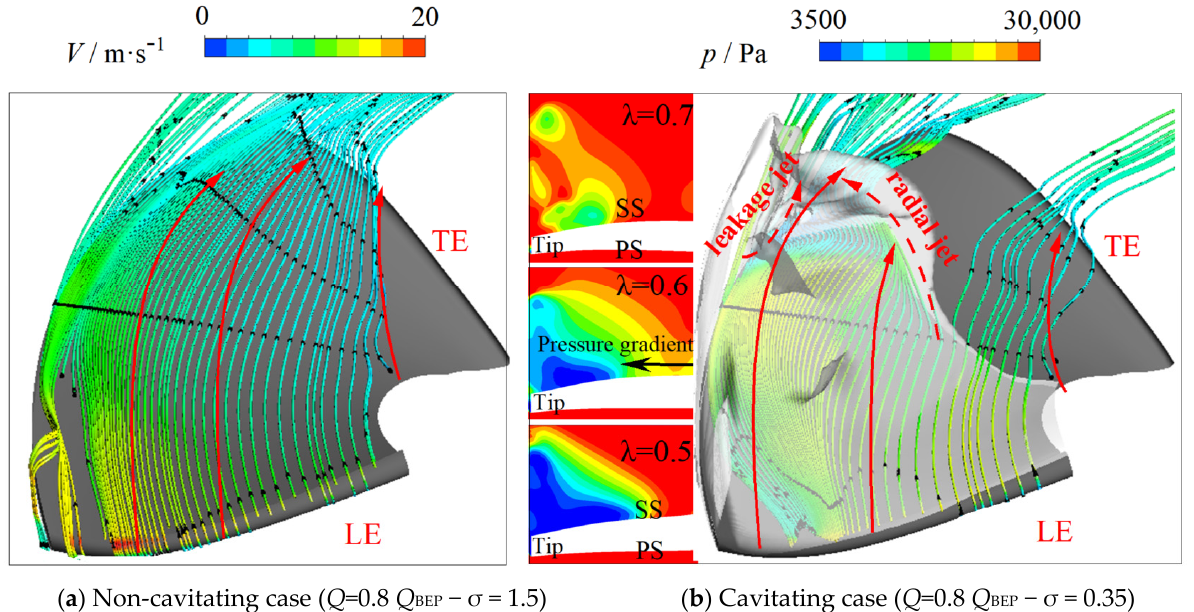
Figure 12. Comparison of blade surface streamlines and cavitation distribution on the suction surfaces of the non-cavitating and cavitating cases.